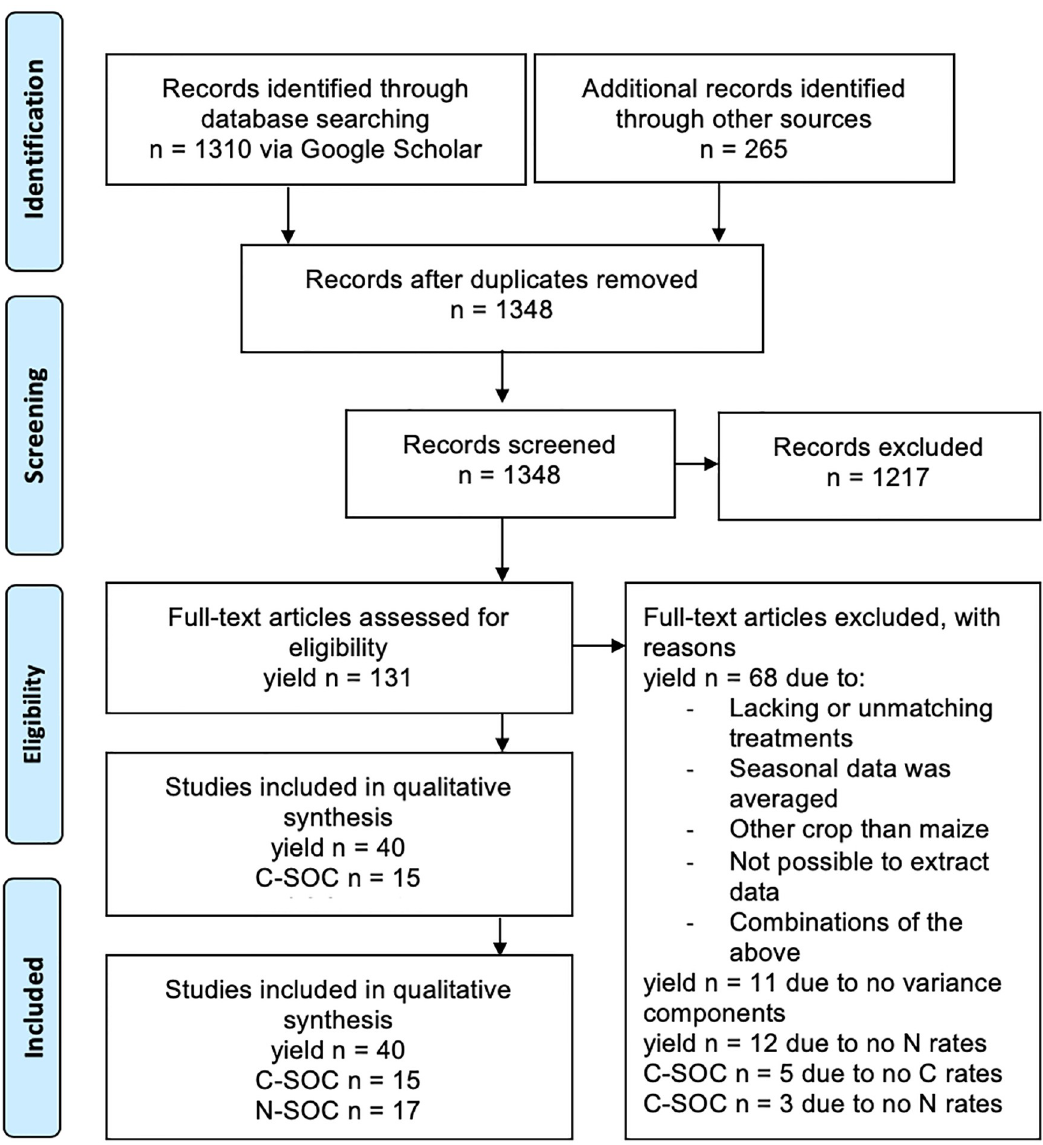
Fig 1. Preferred Reporting Items for Systematic Reviews and Meta-Analysis (PRISMA) Flow Chart describing the protocol used for searching, identifying, and selecting publications for the current meta-analysis. ‘n’ represents the total number of studies, or for the specific analyses if specified (yield, C-SOC, and